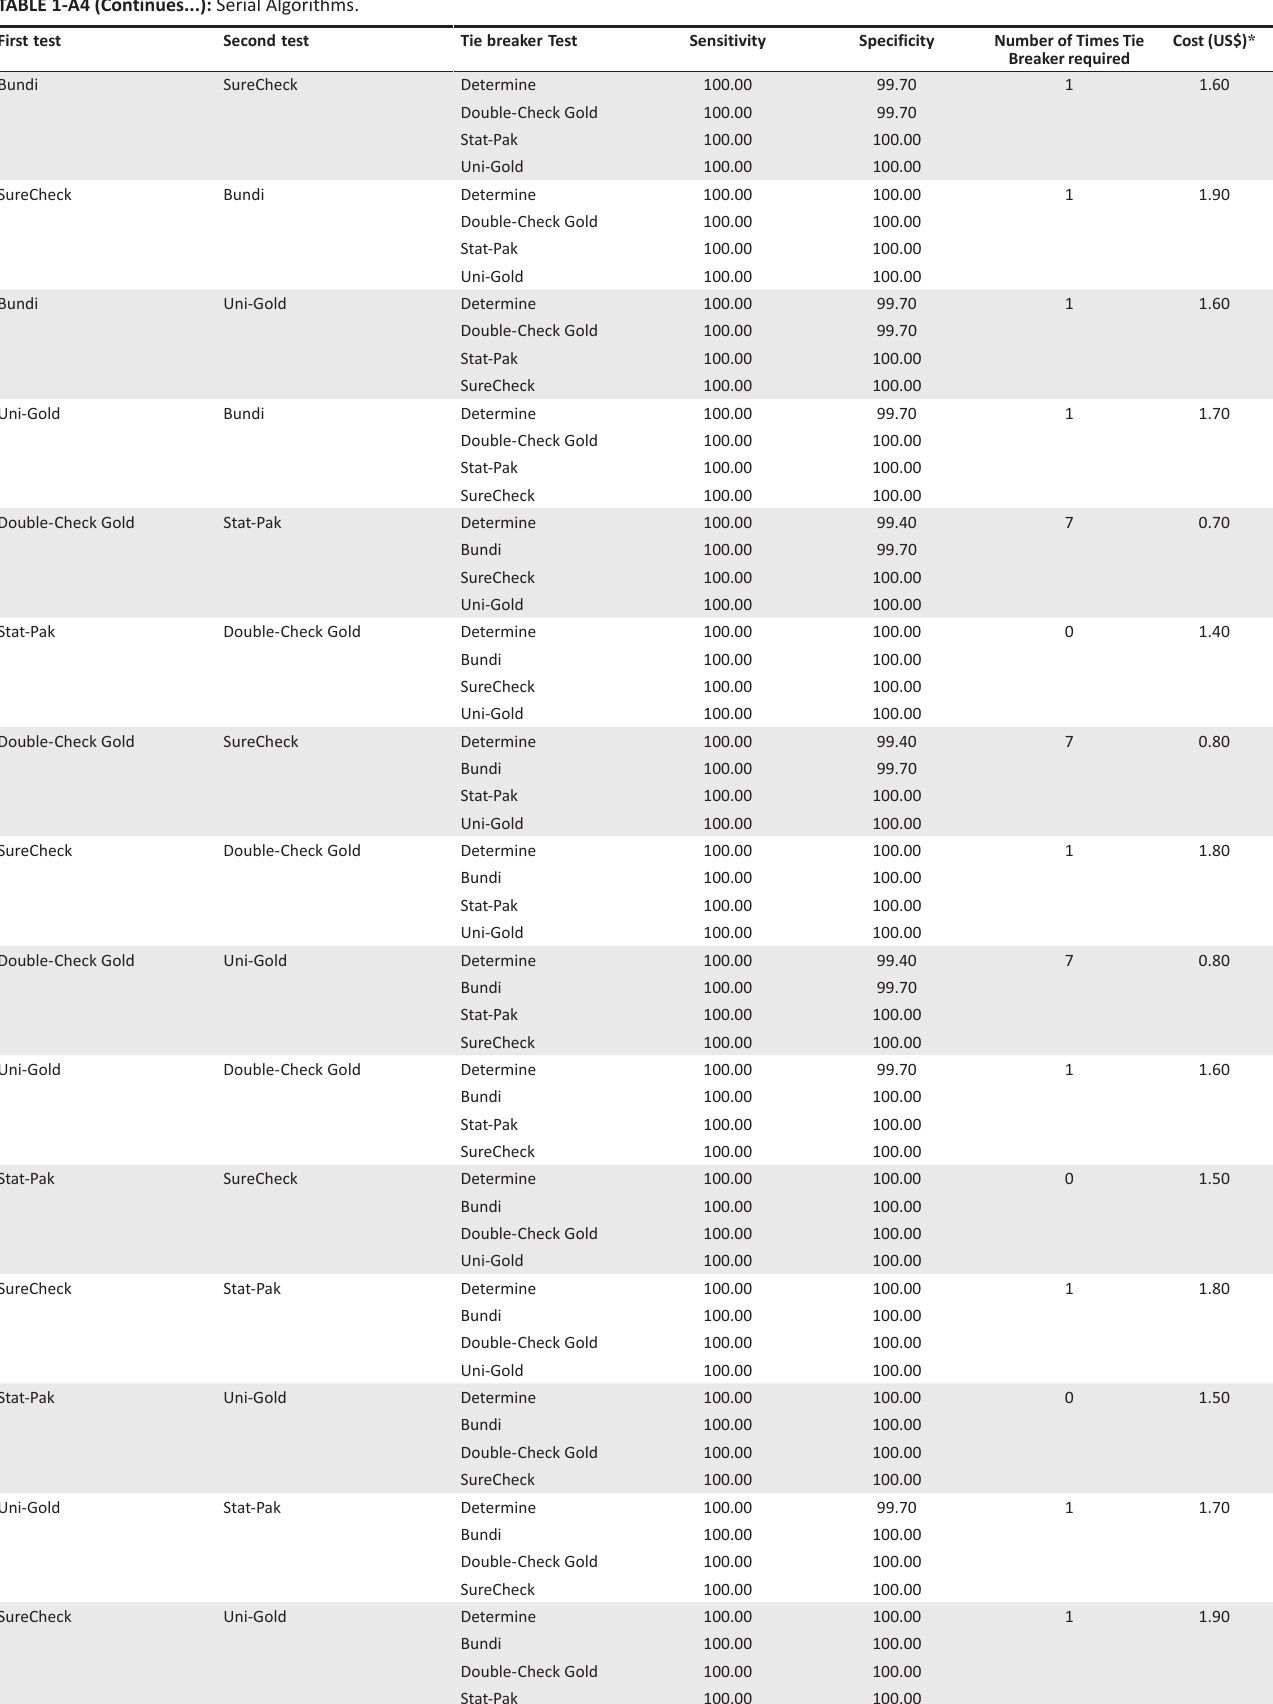
TABLE 1-A4 (Continues...): Serial